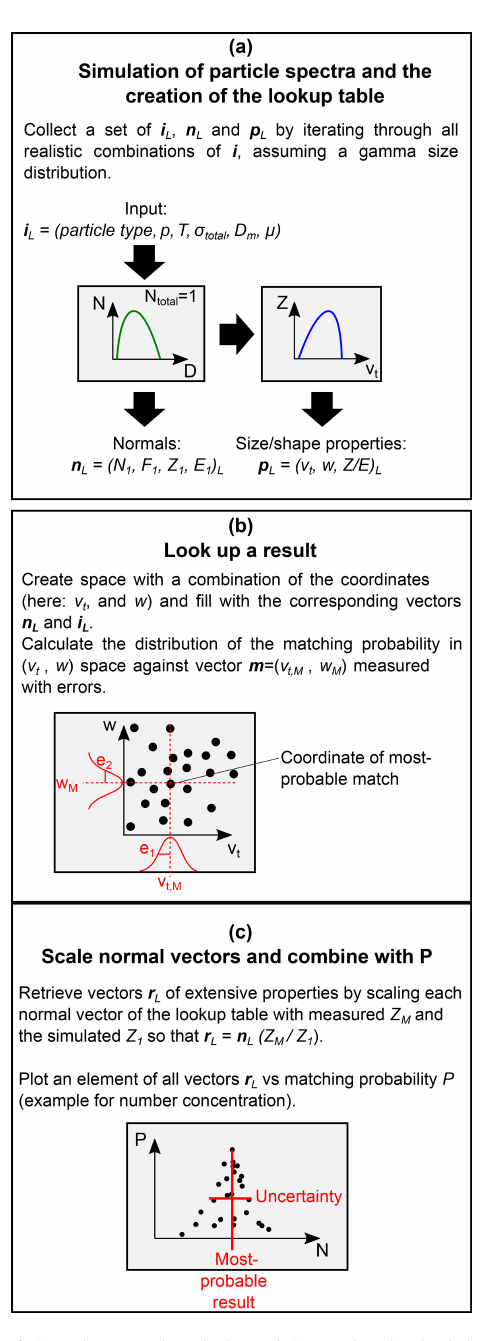
Figure 6. Step-by-step description of the retrieval principle. (a) A lookup table with parameters observable with lidar and radar is cre- ated with a set of combinations of particle shape, p , T , σ total , D m and µ . (b) The matching probability between the measured param- eters and the simulated parameters is searched in the lookup table, resulting in estimations of D m and µ . (c) The PSD created with the retrieved estimations of D m and µ is scaled with extensive param- eters measured with lidar or CR ( E or Z , respectively). The full width half maximum of the distribution of matching probabilities is considered the uncertainty of the retrieved results. More explanation is given in the